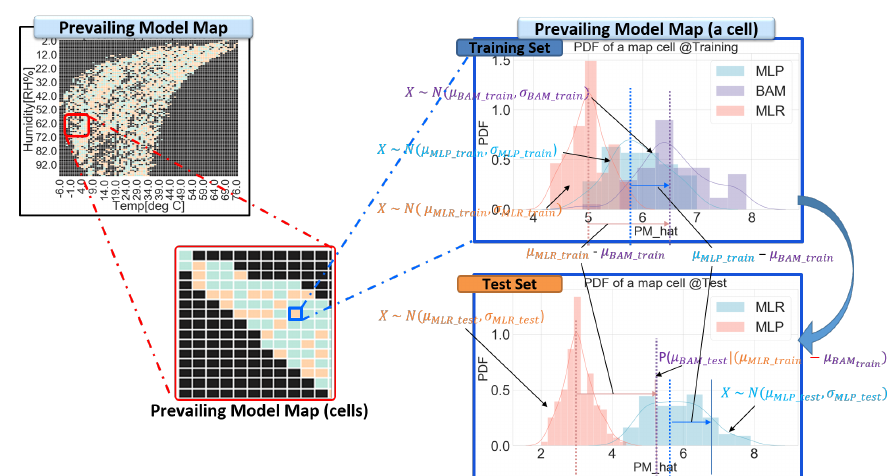
Figure 9. Prevailing model map and prevailing model map (segmented cell). A cell ( Blue box ) is segmented by the allocated inputs, and it has means and standard deviations of calibration models and BAM. The cell offers the prevailing model and its residual for the allocated input.